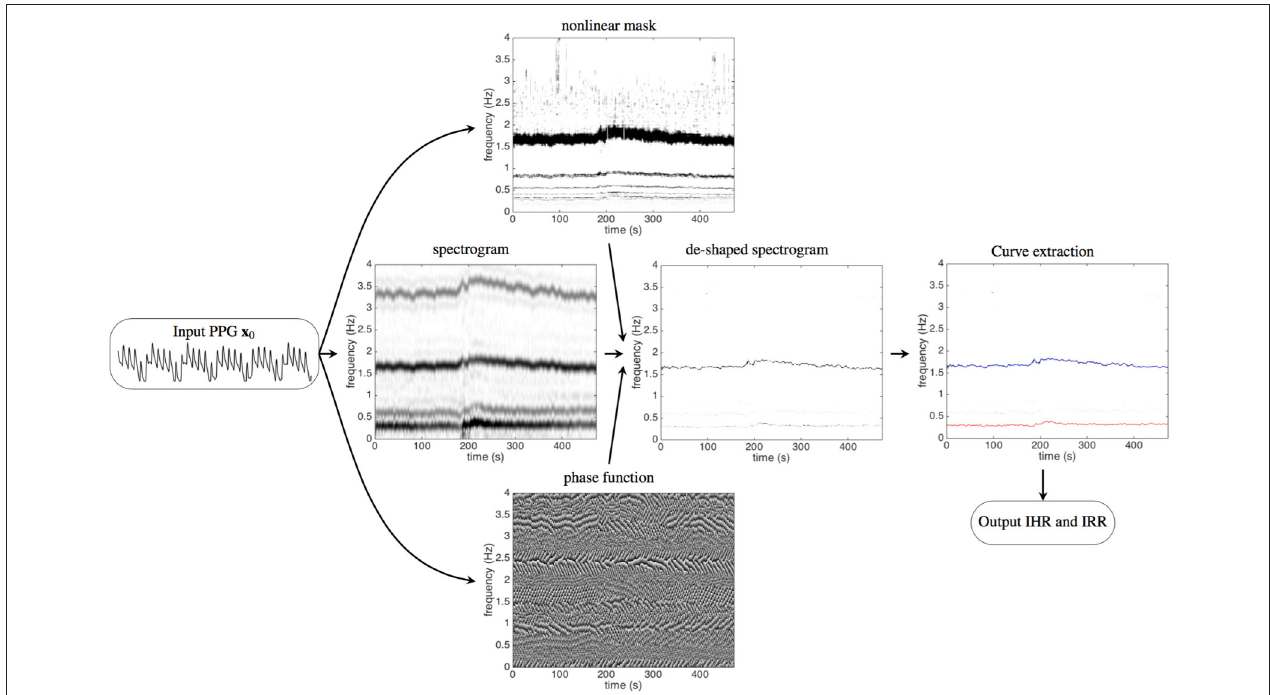
FIGURE 1 | The flow chart of the proposed algorithm, deppG, to extract the instantaneous heart rate (IHR) and instantaneous respiratory rate (IRR) from the recorded PPG signal. A typical recorded PPG signal lasting for 20 s is shown on the left. The short time Fourier transform (STFT), and hence the spectrogram, of the input PPG signal are then evaluated. The intensity of the spectrogram at a point ( t , ξ ) in the time-frequency plane indicates how strong the signal oscillates at time t and frequency ξ . The dark curve around 1.6 Hz represents the IHR, while the gray curve around 3.2Hz (and 4.8 Hz, 6.4 Hz, etc. The frequency axis above 4 Hz is not shown) comes from the non-sinusoidal oscillation of the cardiac activity. Similarly, the dark curve around 0.3 Hz represents the IRR, while the gray curve around 0.6 Hz comes from the non-sinusoidal oscillation of the respiratory activity. With the STFT and the spectrogram of the PPG signal, the nonlinear mask is then designed from the spectrogram and the phase function is determined from the STFT. The intensity of the phase function at a point ( t , ξ ) in the time-frequency plane indicates the angle of the complex value of the STFT at time t and frequency ξ , which ranges from 0 to 2 π . By applying the nonlinear mask and the phase function of the STFT to the spectrogram, the spectrogram is improved and we obtain the de-shaped spectrogram. The darker curve around 1.6 Hz represents the IHR and the lighter curve around 0.3 Hz represents the IRR. The curves corresponding to the IHR and IRR are extracted from the de-shaped spectrogram, which are shown as the red and blue curves respectively superimposed on the de-shaped